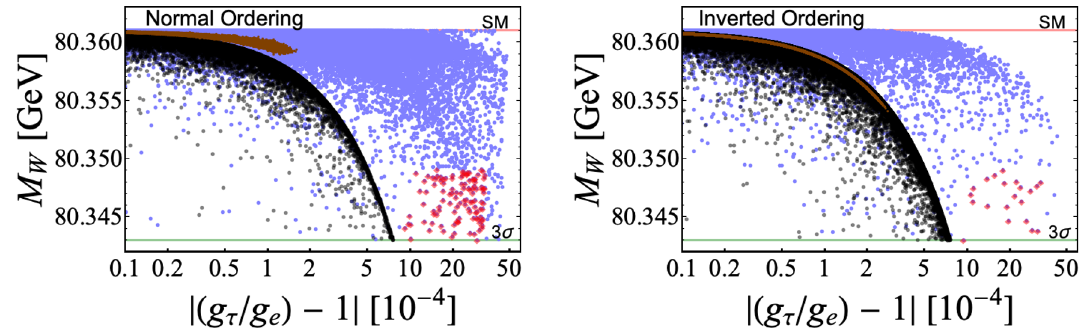
Figure 3 . Correlations among M W and deviations of g τ /g e from universality. The colours are the same as in figure